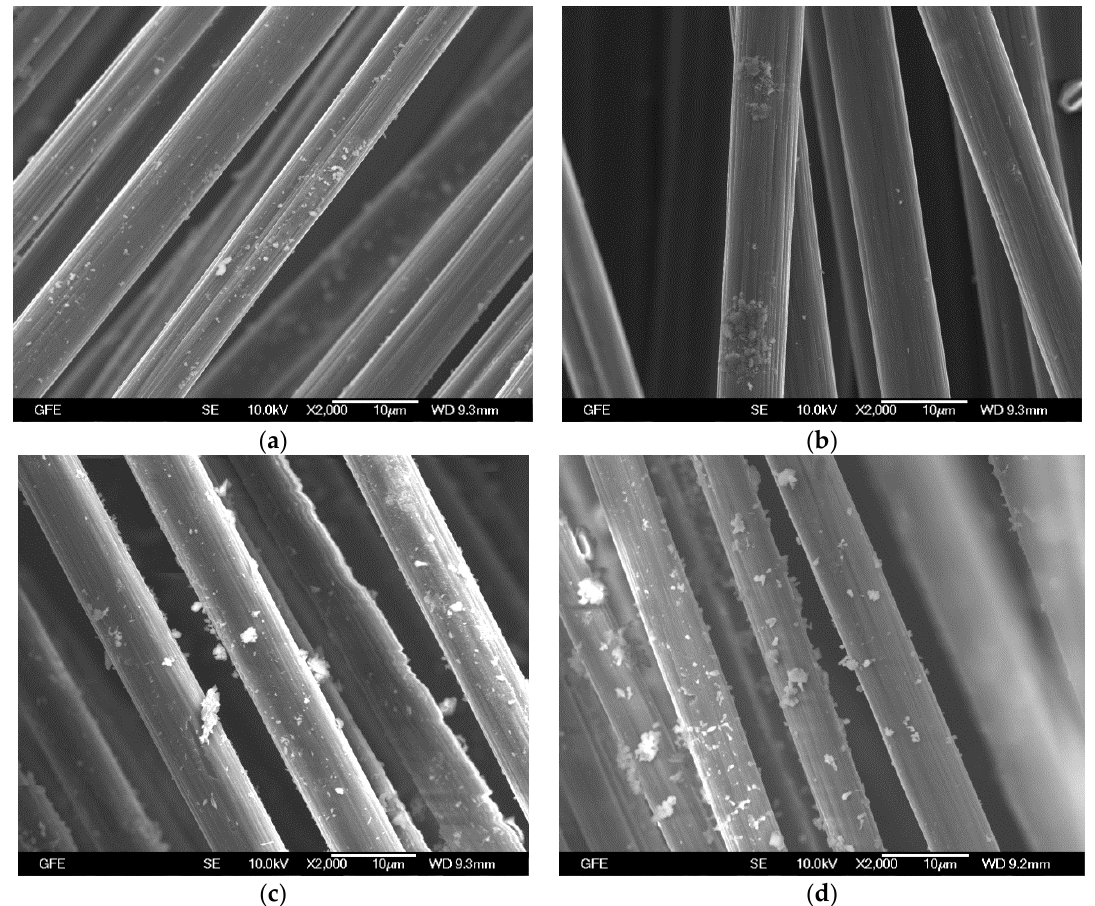
Figure 16. SEM images of UC_WS: unpolarized reference ( a ), after polarization at level 1 ( b ), level 2 ( c ) and level 3 ( d ).